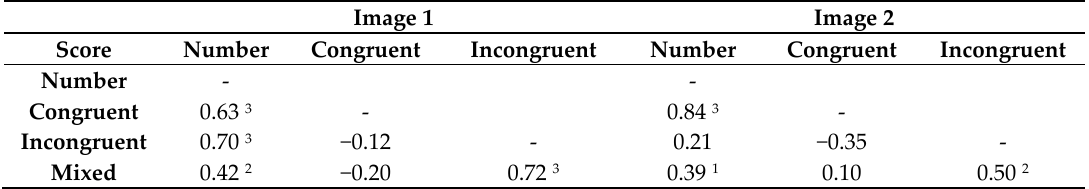
Table 5. Correlation among the scores of the Image Completion Task (ICT), image 1 and 2 (N = 27). Image 1 Image